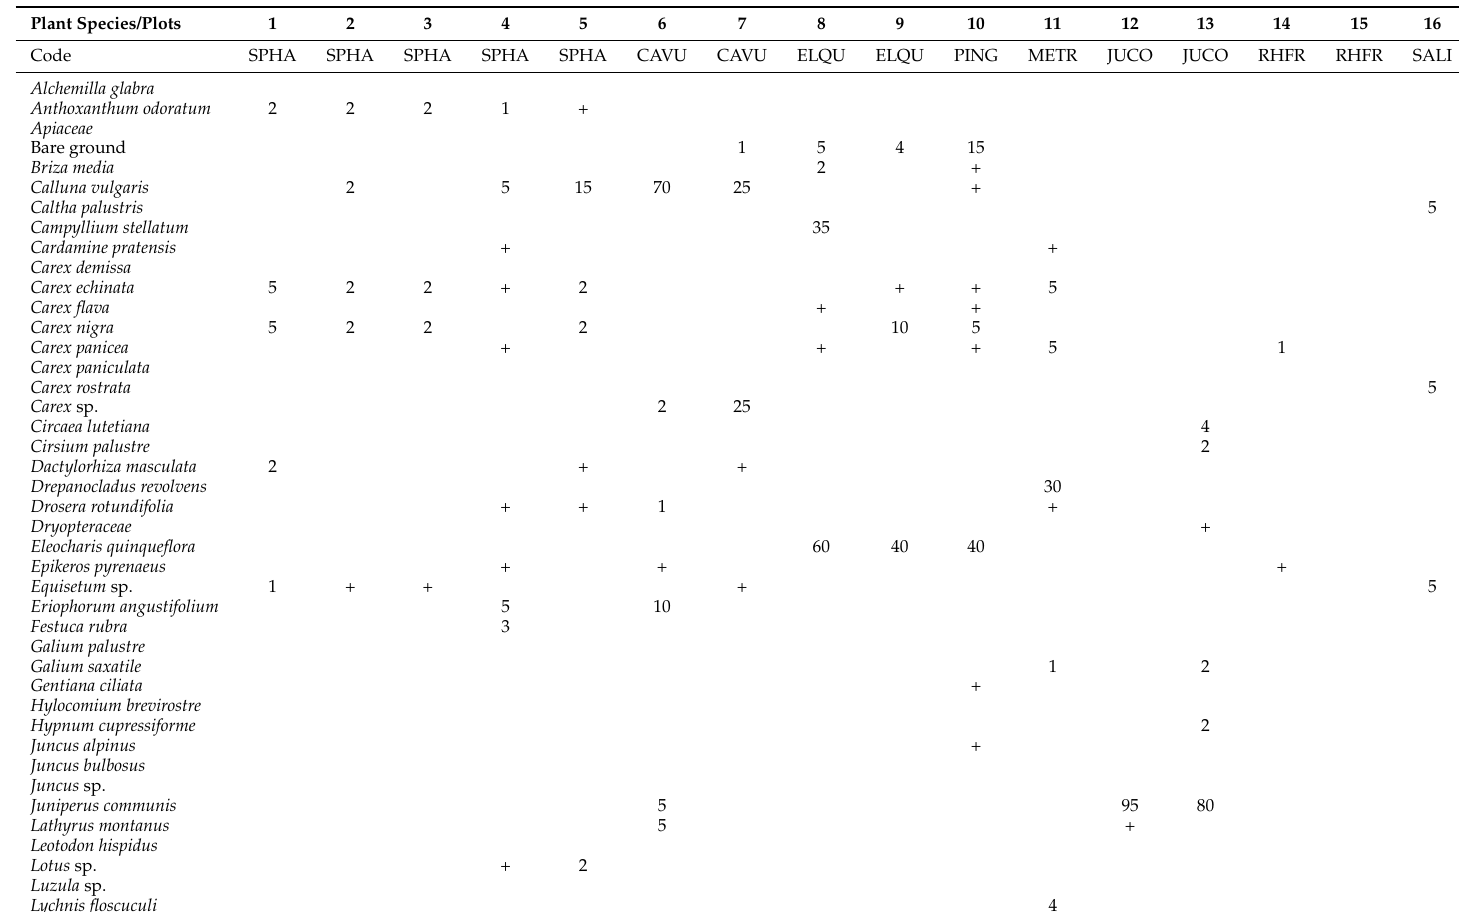
Table A1. Presence ( + ) and actual cover percentage of plant species collected on Bernadouze peatbog (Ariège, France) by Florence M AZIER & Nicolas DE M UNIK (2014/09/04 &